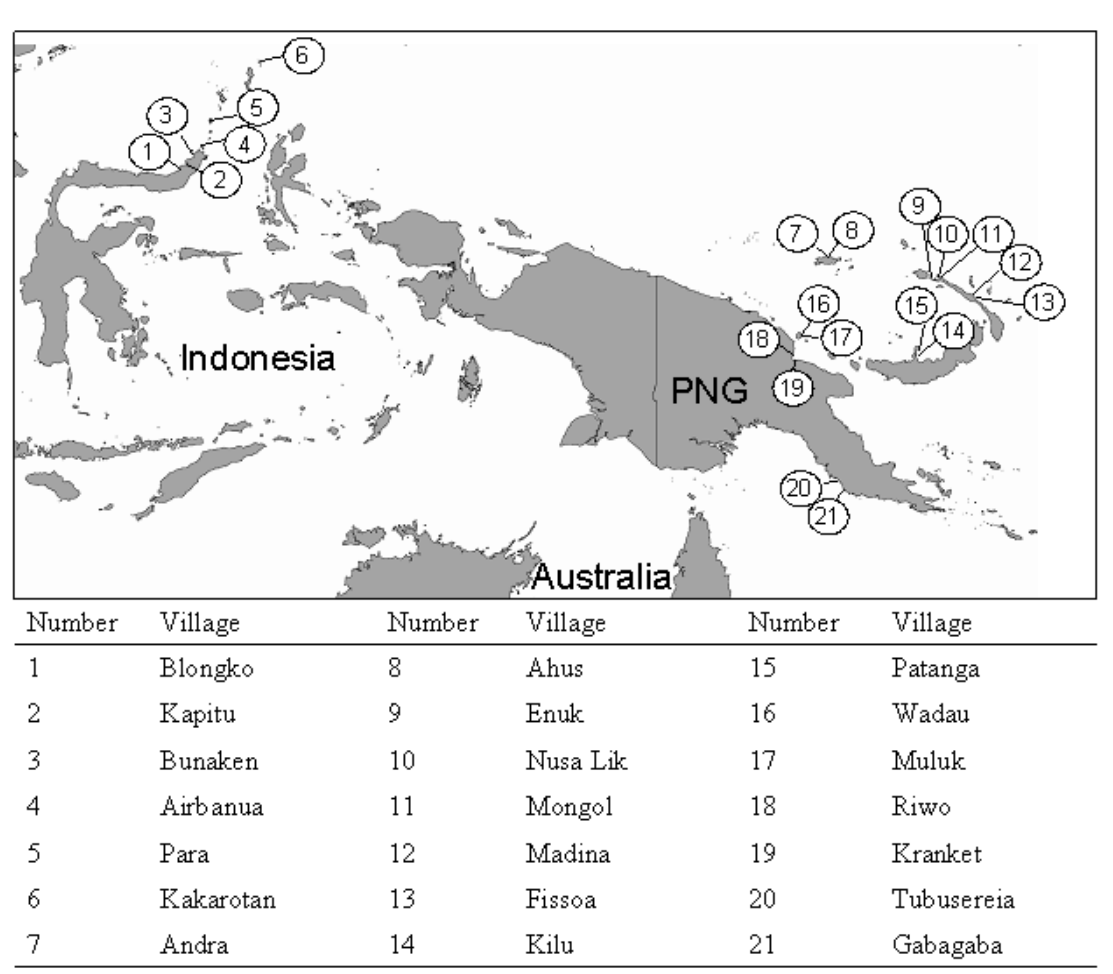
Fig. 1 . Map of study